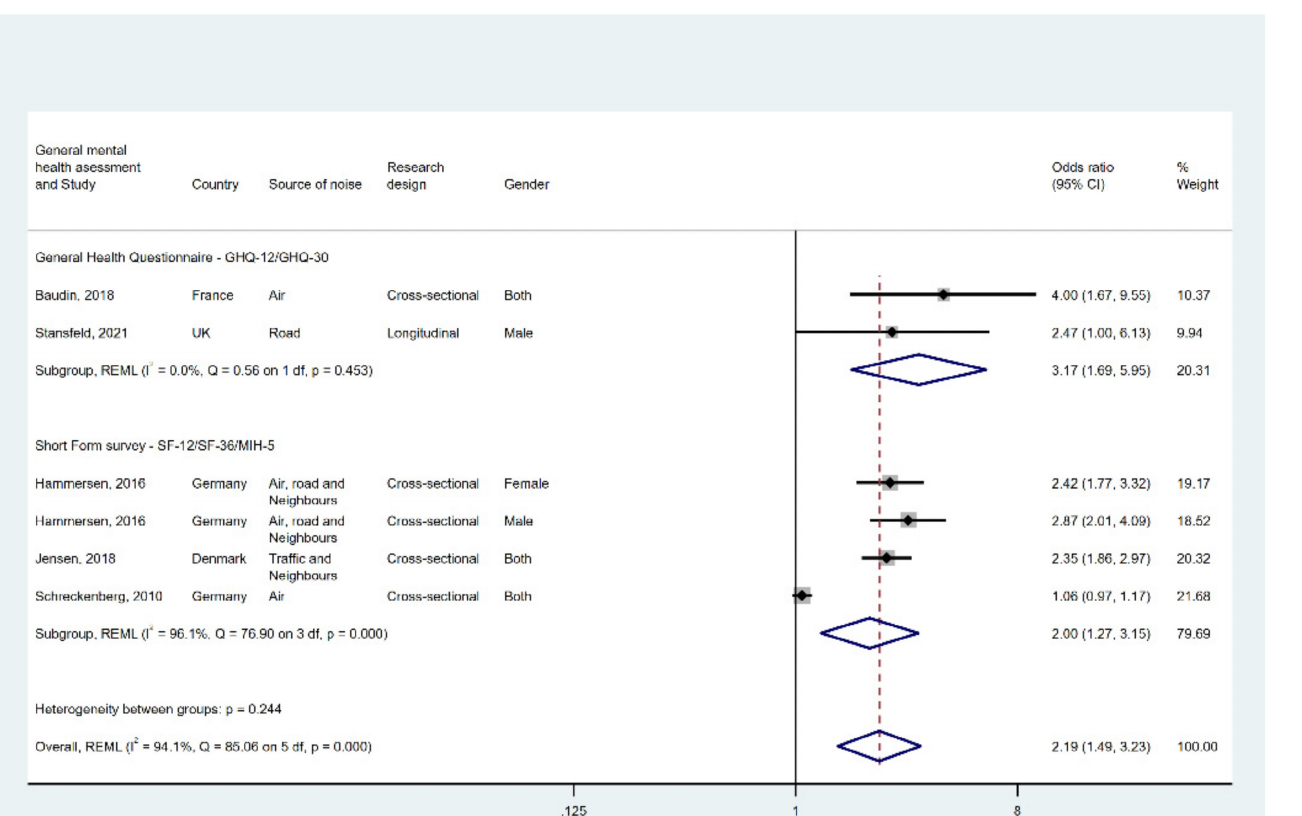
Figure 4. Forest plot displaying the link between high noise annoyance and general mental health. Note: weights and between-subgroup heterogeneity text are from random-effects